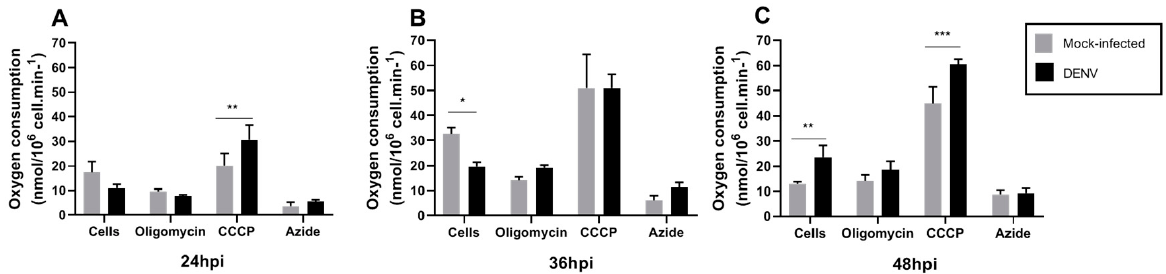
Figure 4. Typical profile of oxygen consumption in C6/36 mock and DENV2-infected cells. C6/36 cells were infected with DENV2 at MOI 5 and incubated at different time points of 24 hpi ( A ), 36 hpi ( B ), and 48 hpi ( C ). Oxygen consumption trace was determined using a high-resolution Clark-oxygraph in a 1.0 mL water jacket maintained under constant stirring at 28 °C, sequential injections of oligomycin, CCCP, and sodium azide were added. These chemicals act as an ATP synthase inhibitor, mitochondrial uncoupler, and inhibitor of complex IV, respectively. Data are shown as mean ± SD from three independent experiments. Statistical analyses were performed by two-way ANOVA and Sidak´s multiple comparison test. p < 0.05 (*), p < 0.001(**), p < 0.0001 (***). MI: mock-infected; CCCP: carbonyl cyanide m-chlorophenyl hydrazone; hpi: hours post-infection; DENV: dengue